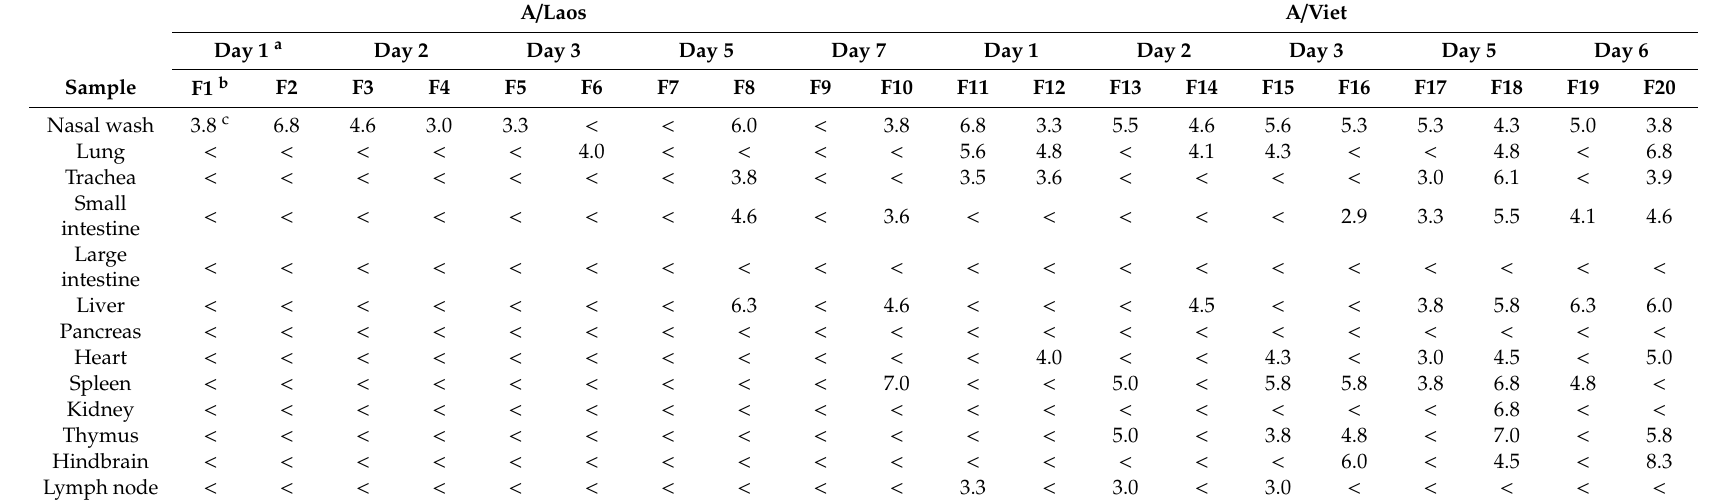
Table 1. Human-adapted H5N1 virus produces a more rapid systemic infection in ferrets than avian H5N1 virus. A /